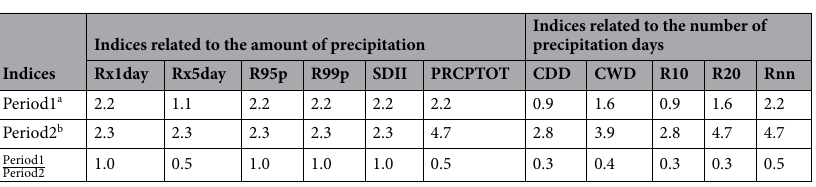
Table 4. Primary period of extreme precipitation indices in Shandong Province. a Period1 represents the primary period of extreme precipitation indices in this study. b Period2 represents the primary period of extreme precipitation indices in the coastal areas of Huanghuai, China (including Shandong